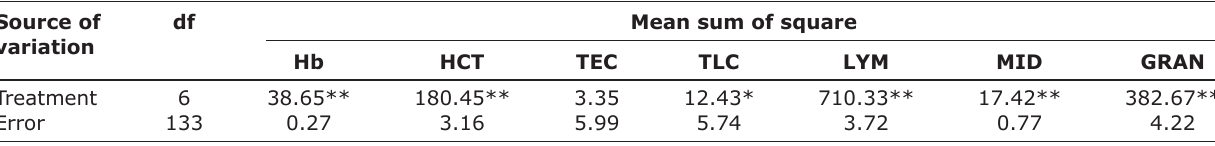
Table-2: Analysis of variance for hematological parameters. Source of df Mean sum of variation